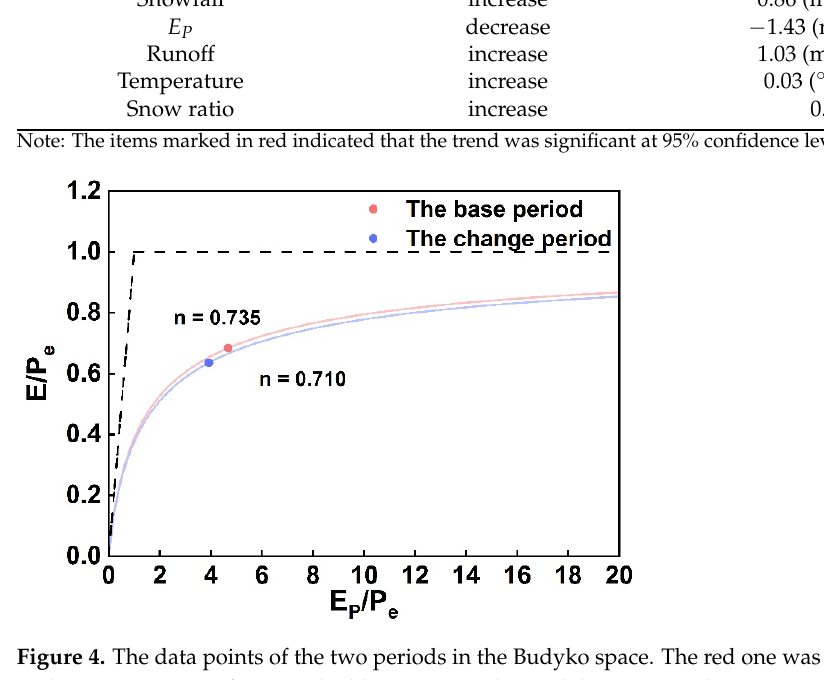
Figure 3. The result of the analysis of annual runoff: ( a ) the M-K test and ( b ) the accumulative anomalies. Table 3. The trend of precipitation, snowfall, E P , runoff, air temperature, and snow ratio in the period from 1960 to 2010. Table 2. The value of annual precipitation, snowfall, average air temperature, snow ratio, E P , runoff, wind speed at 10 m, sunshine time, and relative humidity during the base period (1960–1995) and change period (1996–2010).